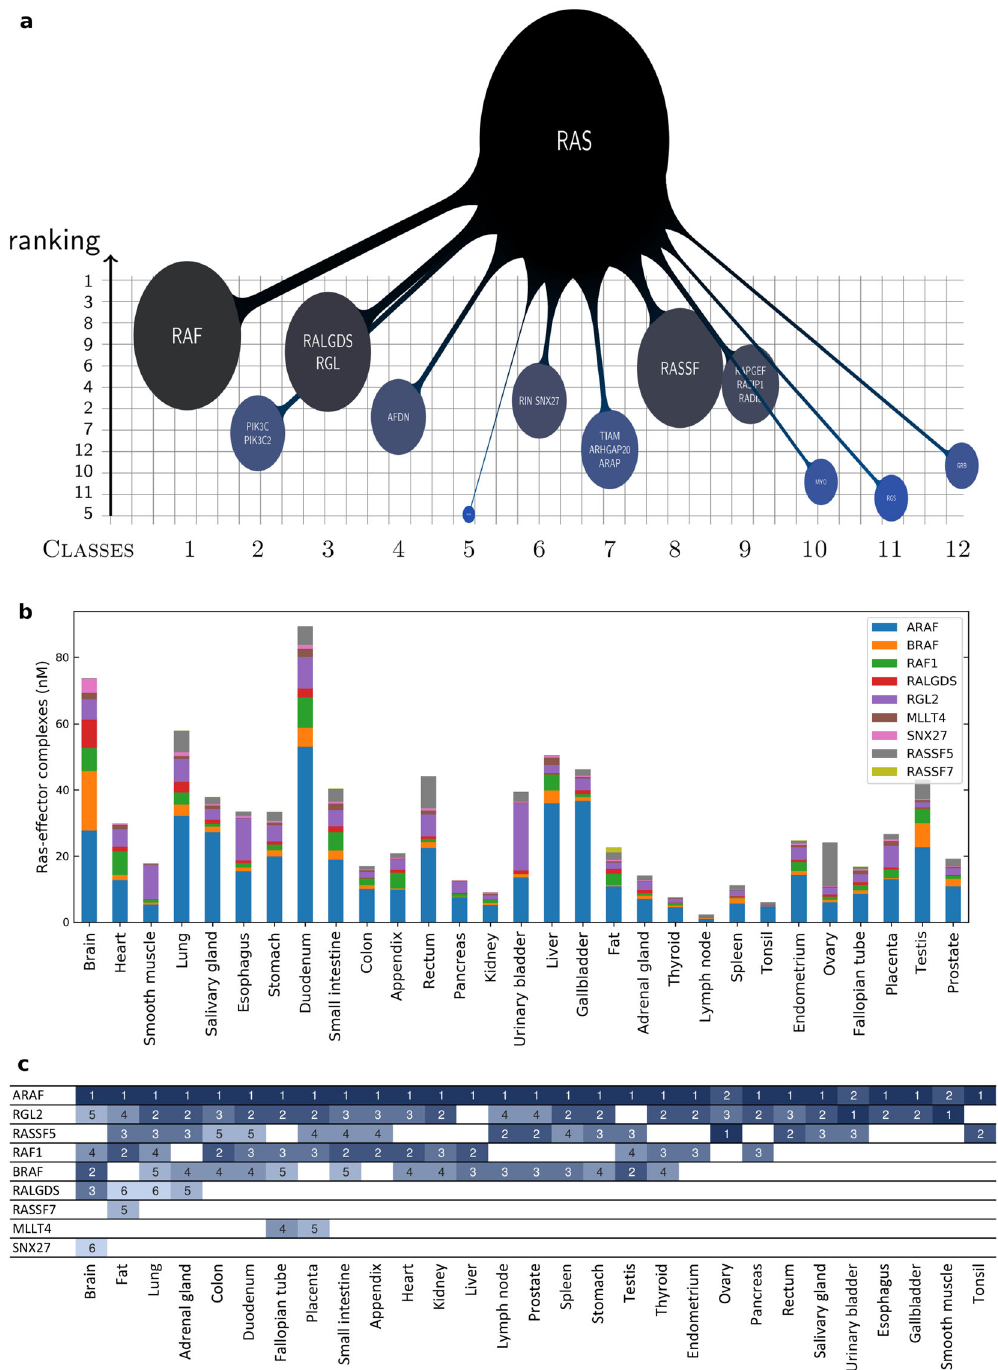
Fig. 2 Hierarchies of Ras-effector complexes and key effectors in 29 human tissues. a Example of an “ octopus ” network representation for the Ras binding pro fi le by class (in lung tissue). The effector classes are ordered along the x -axis and ranked on the y -axis based on their relative amount bound to (20% GTP-loaded) Ras, at steady state. The bubbles on the grid show the repartition (in percentage) of such complexes, according to a discrete and a continuous scale, i.e. size and color variation, respectively. b Tissue-speci fi c variation of Ras-effector complexes (in nM) for a set of 9 effectors that are in complex with Ras for a proportion of ≥ 5% in at least one tissue. c Ranking of the complexes associated to the nine effectors of panel b (deduced from the y -axis of the octopus plots, like in panel a ). Color code from highest (1st) to lowest (6th) ranked (from dark to light blue) shows that these key effectors usually enter the list of the top six most abundant Ras complexes, if expressed. Tissues on the x -axis are ordered according to the number of involved key effectors per signaling hub protein such as Ras, for which different ranges of complexes is less intuitive – hence we calculated tissue-speci fi c af fi nity constants and different ranges of concentrations of complexes using our mechanistic model. To obtain further effector molecules converge, and for which competition among insights into the determinants of complex formation at the Ras effectors is important, predicting the amount of Ras-effector protein hub and to explore how this potentially differs across